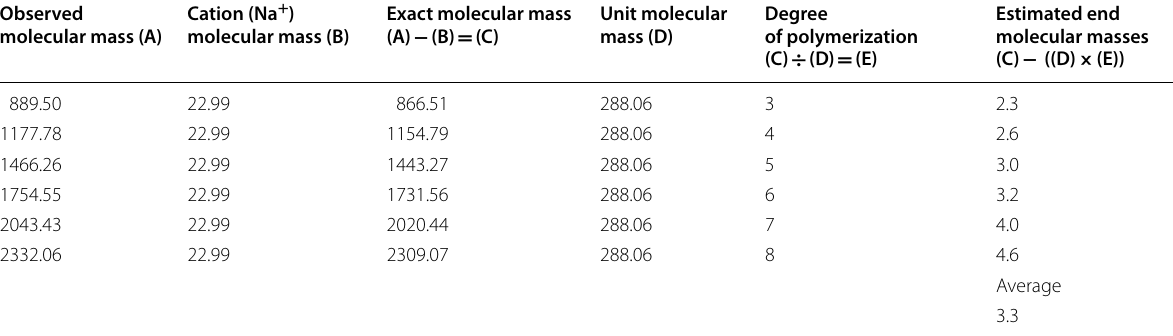
Table 2 Estimation of end structures of PAC from A. zerumbet Observed molecular mass